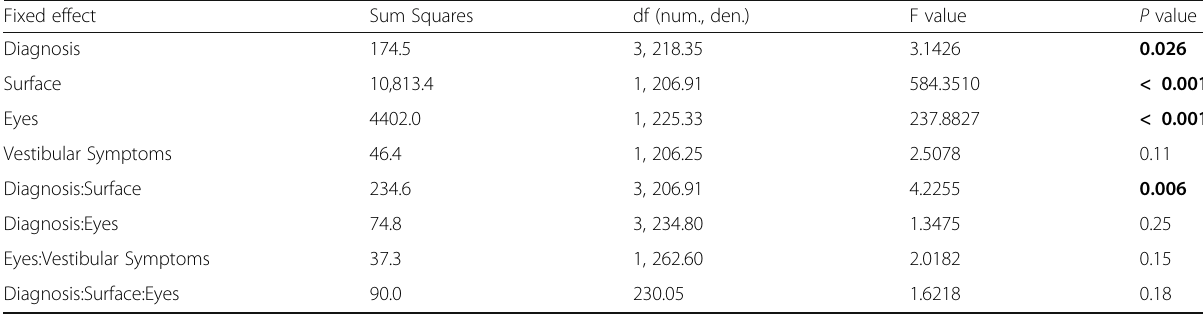
Table 2 Results of F-tests for individual fixed-effects terms using Satterthwaite approximation for degrees of freedom Fixed